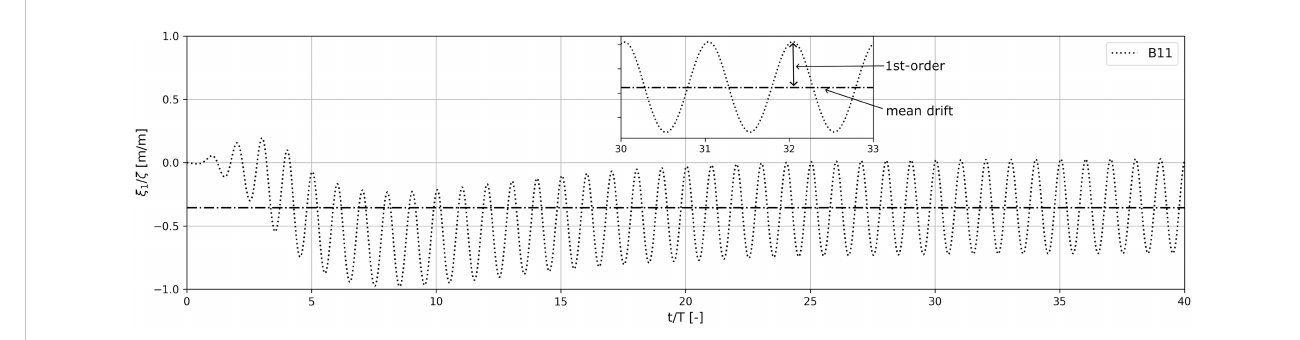
FIGURE 7 Sample time series of surge motion of the module at R1C1 in a regular wave of w = 0.33 rad/s.